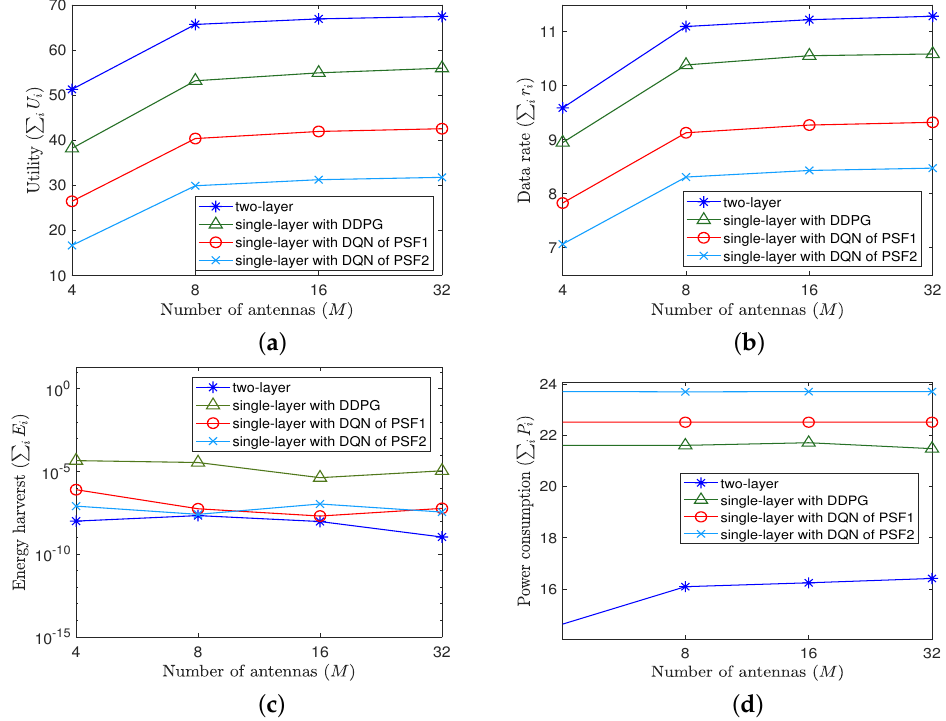
Figure 4. Impacts of varying the number of antennas ( M ) upon ( a ) utility, ( b ) data rate (bps), ( c ) energy harvesting (J), and ( d ) power consumption